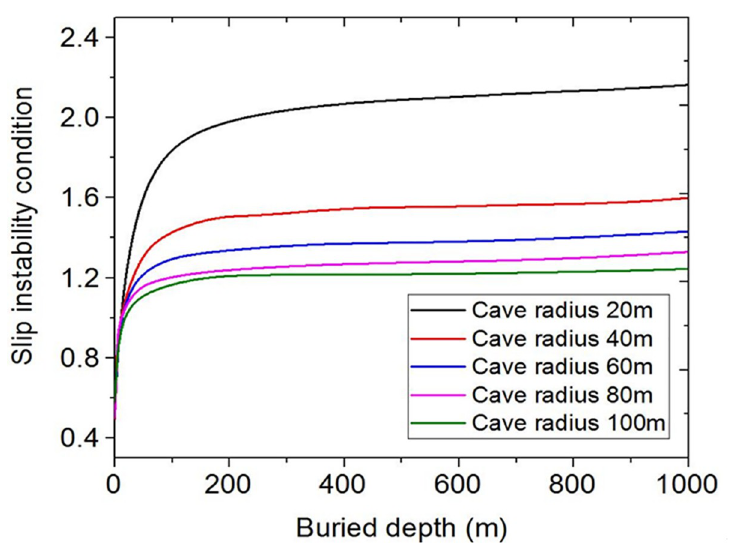
Fig 3. Influence curves of different cave radius.